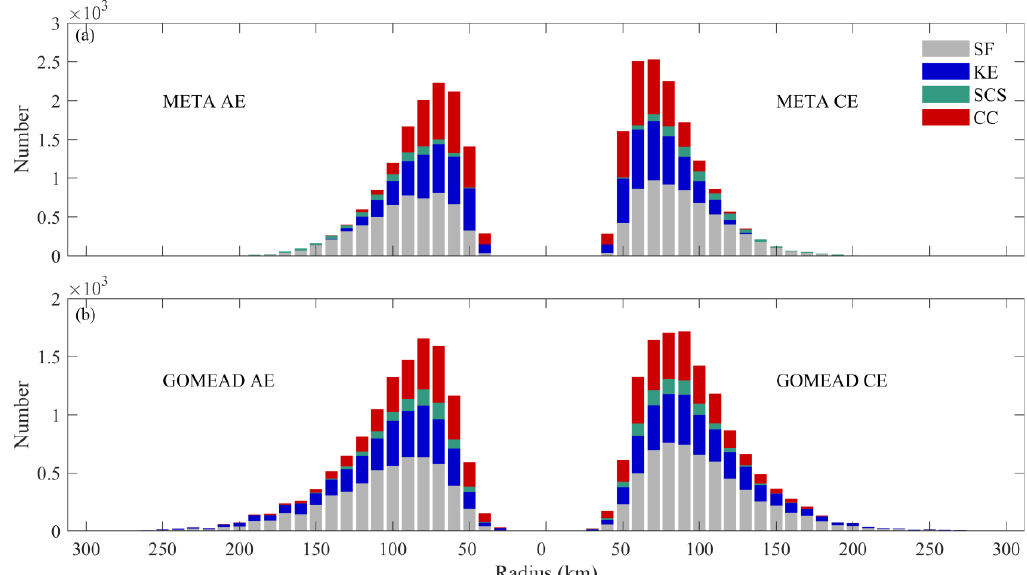
Figure 3. Histograms of eddy radii of ( a ) META and ( b ) GOMEAD datasets.